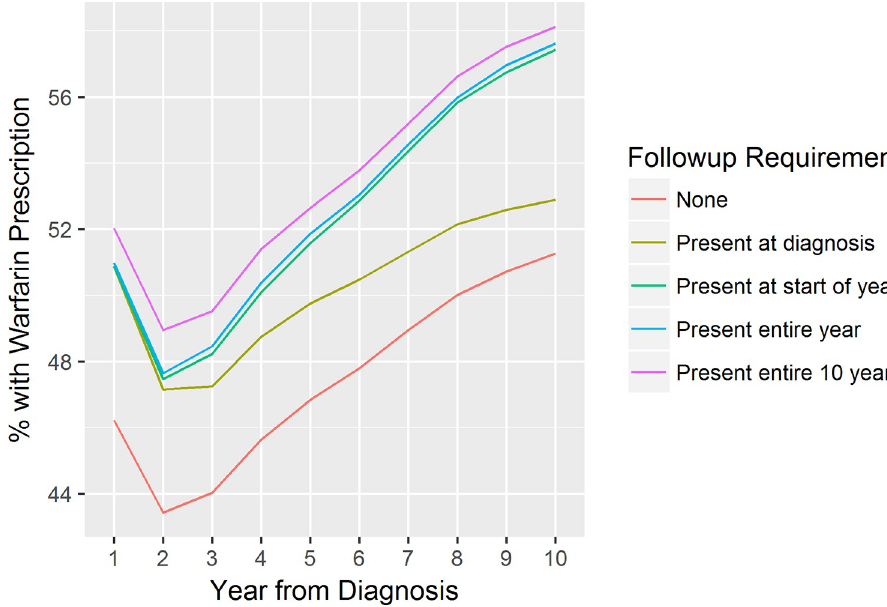
Fig 3. Measured rate of warfarin prescription by year from AF diagnosis.